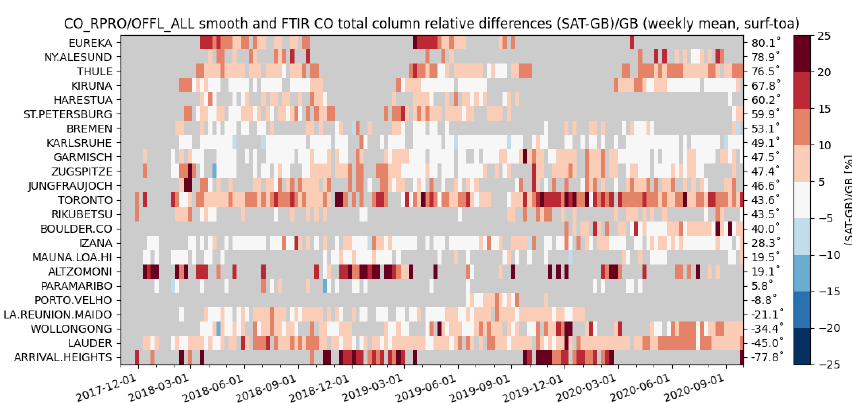
Figure 31. Mosaic plots showing relative biases between co-located S5P and NDACC CO column data smoothed with S5P a priori and ad- ditionally smoothed with the S5P column-averaging kernel at 23 NDACC stations within the period between November 2017 and September 2020. Spatial co-location with radius of 50km and time of ± 3h around the satellite overpass was used. The time resolution of the data shown here is weekly. The stations are sorted with decreasing latitude.